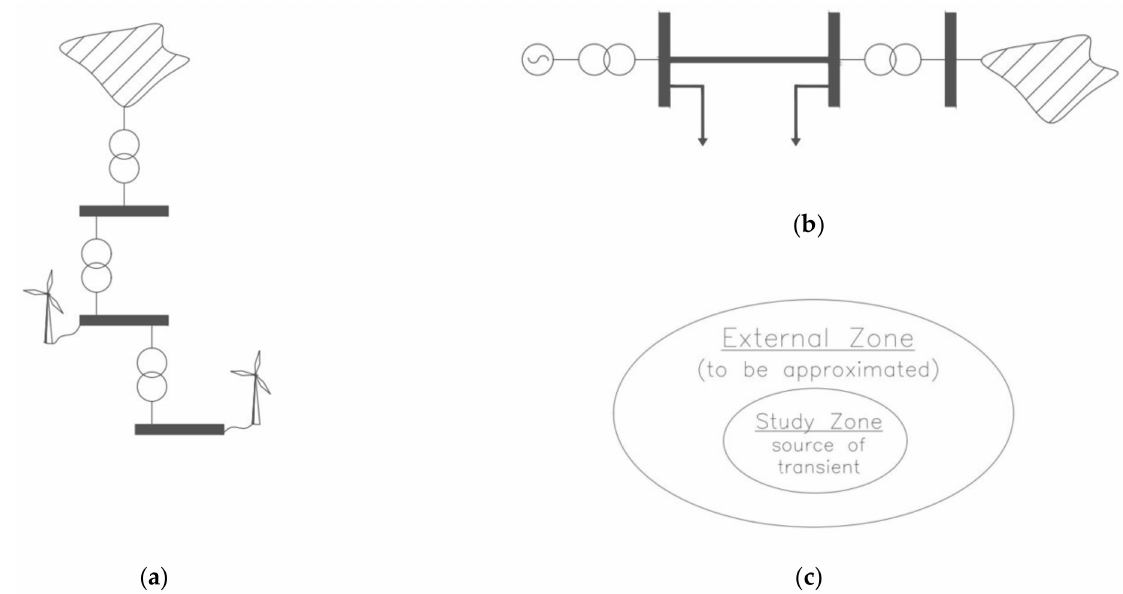
Figure 1. Investigated object supplied by ( a ) simple system, ( b ) double separated system, ( c ) double connected